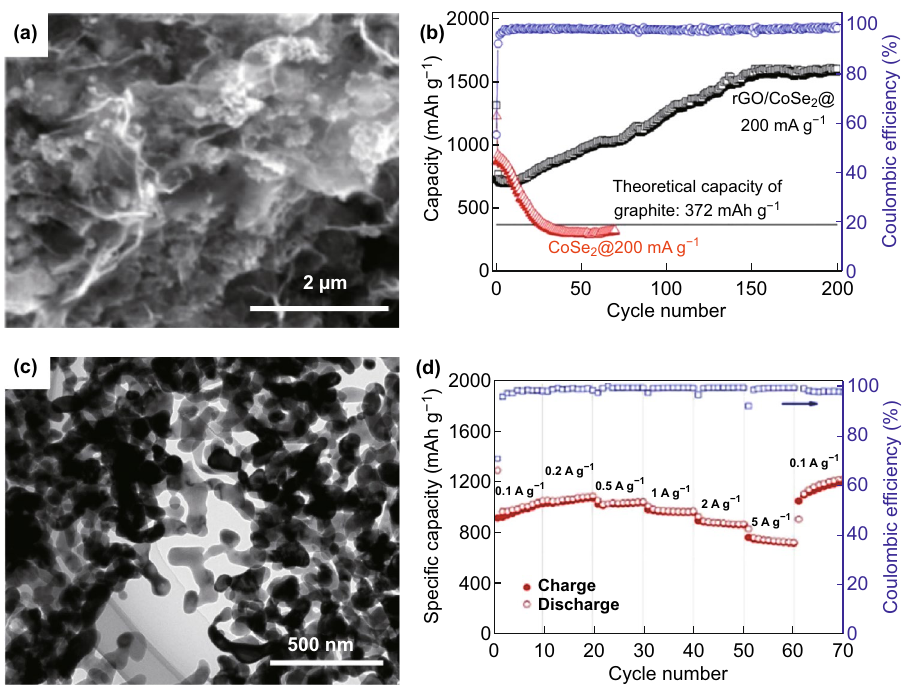
Fig. 3 a SEM images of rGO/CoSe 2 composite. b Cycling performance of rGO/CoSe 2 composite. c TEM image of porous Cu-doped CoSe 2 . d Capacitances at current densities varying from 0.1 to 5.0 A g −1 . Adapted from Refs. [44, 45] with permission. Copyrights: 2015 (2017), Wiley-